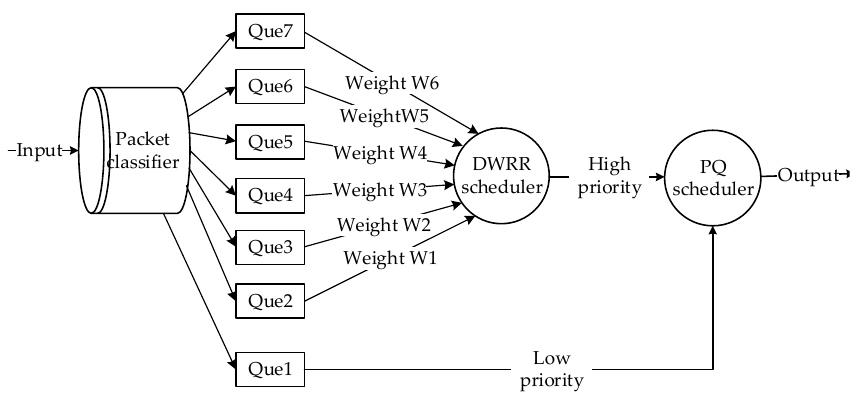
Figure 9. Algorithm principle diagram of PDWRR.